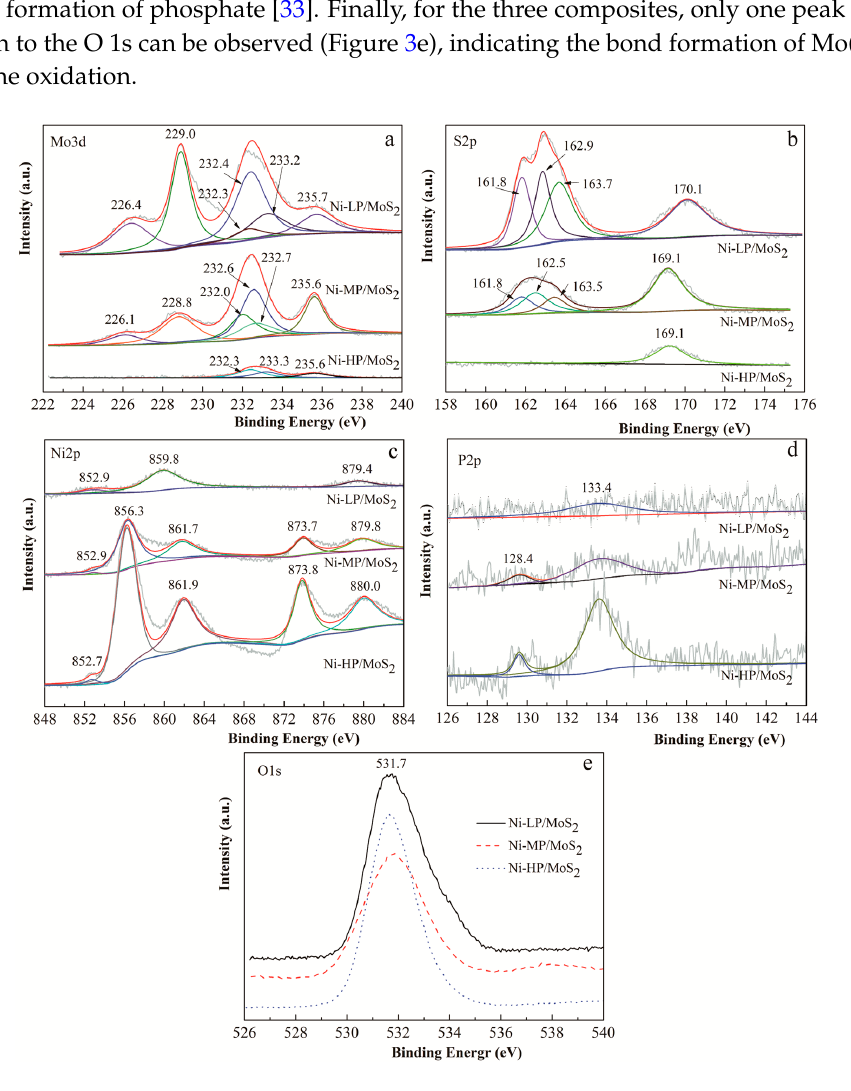
Figure 3. X-ray photoelectron spectra (XPS) of three Ni–P/MoS 2 composites. ( a ) Mo 3d; ( b ) S 2p; ( c ) Ni 2p; ( d ) P 2p; and ( e ) O 1s.